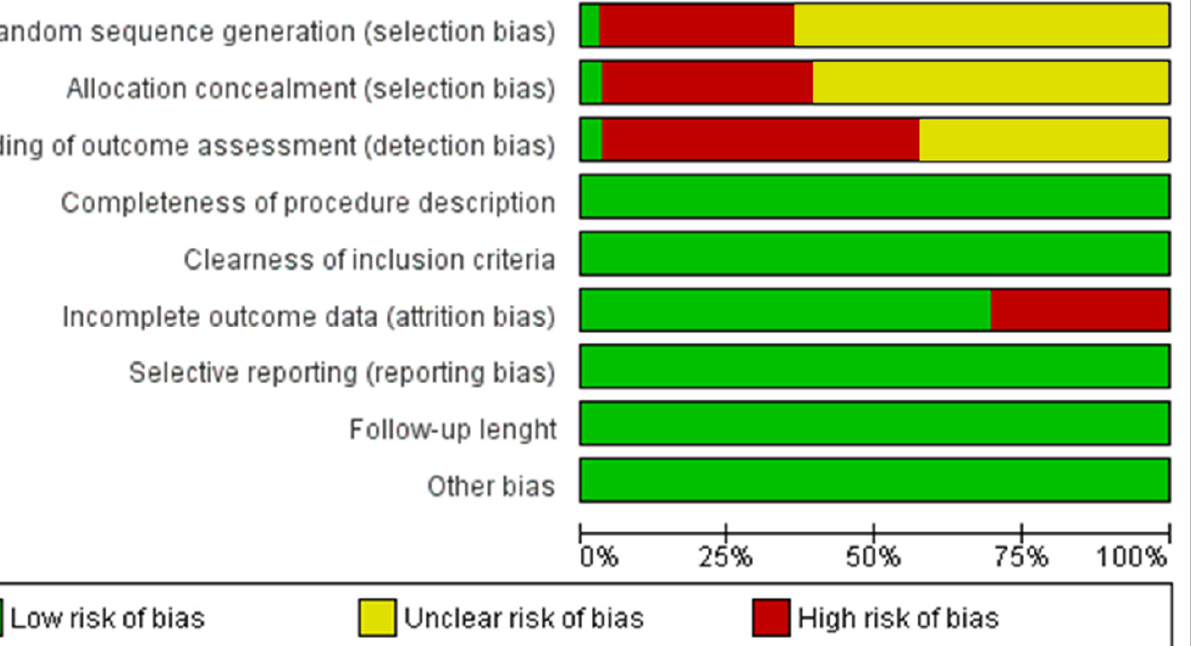
Figure 2. Summary of the risk of bias assessment of the studies included.